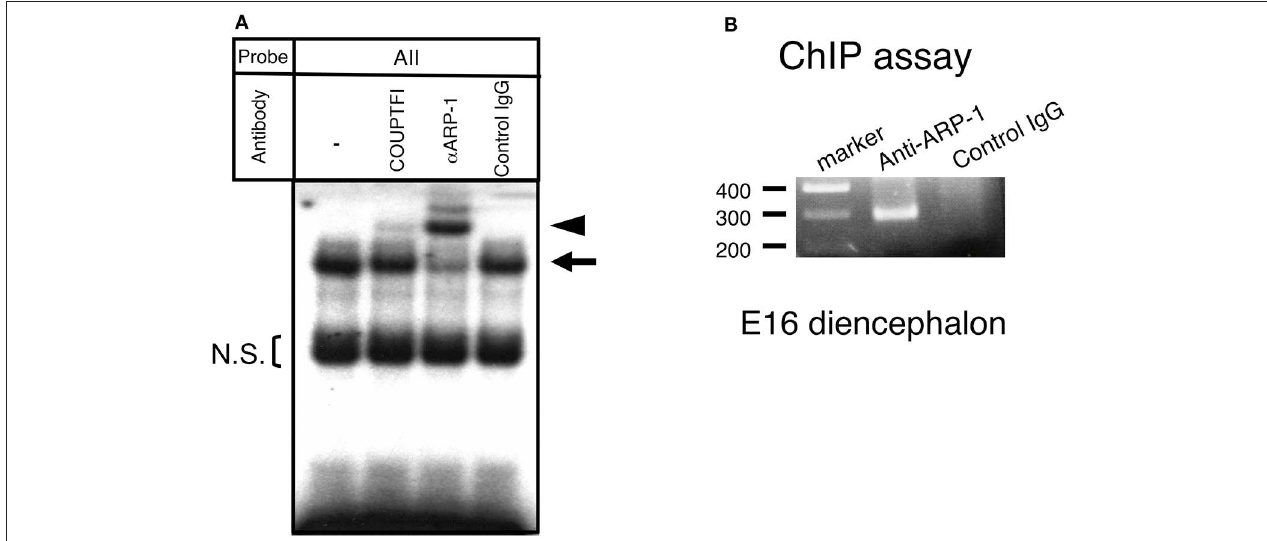
FIGURE 3 | ARP-1 protein binds to the aro-AII sequence in vivo . (A) A gel shift assay was performed using 5 µ g of nuclear protein or an aliquot of in vitro synthesized ARP-1 protein. For supershift assays, nuclear protein was incubated with 2 µ g of the indicated antibody on ice for 30min before the addition of a radiolabeled probe. The probe/nuclear protein complex and supershift signals are indicated by the arrow and arrowhead, respectively, on the left side. The bracket shows the non-specific signals (N.S.). A 200-fold molar excess of unlabeled probe was used in the competition assay. The probe/ARP-1 complex and supershift signals are indicated by the hatched arrow and arrowhead, respectively, on the right side. (B) A chromatin immunoprecipitation assay confirmed that ARP-1 could associate with the aro-AII site in the fetal mouse brain in vivo . Fresh diencephalic regions of E16 mouse brains were treated with 1% formaldehyde. The fixed tissues were dissolved, and the DNA was sheared and immunoprecipitated with anti-ARP-1 antibody or preimmune IgG. The recovered genomic DNA was subjected to PCR with primers specific for the mouse aromatase gene as shown in Figure 1 .